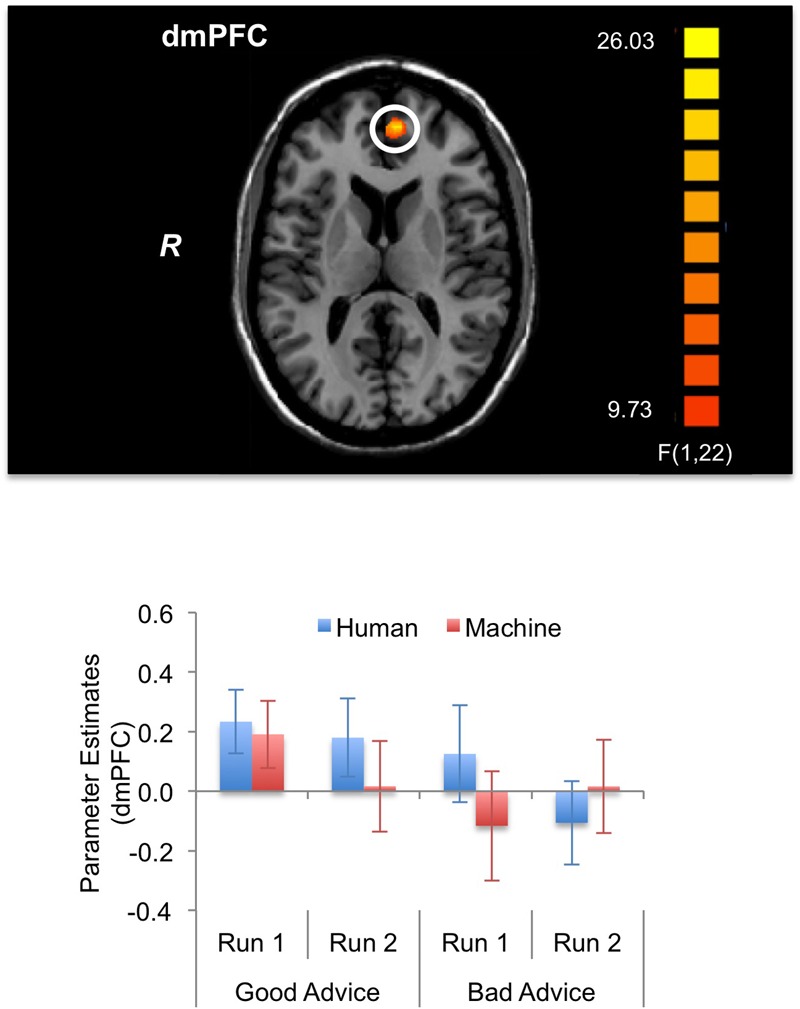
Brain activations during feedback phase (α < 0.05, k = 14). The three-way interaction (Advice × Run × Agent) during the feedback phase significantly activated the left dorsomedial prefrontal cortex (dmPFC). The activation pattern shows lower activation for bad advice compared to good advice during run 2 for the human agent. The bar plots shown are for visualization purposes.